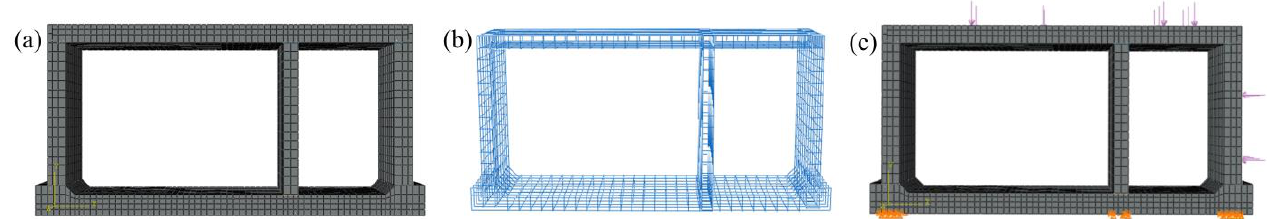
Figure 11. Finite element analysis models of prefabricated underground utility tunnel: ( a ) concrete model; ( b ) reinforcement model; and ( c ) utility tunnel model.